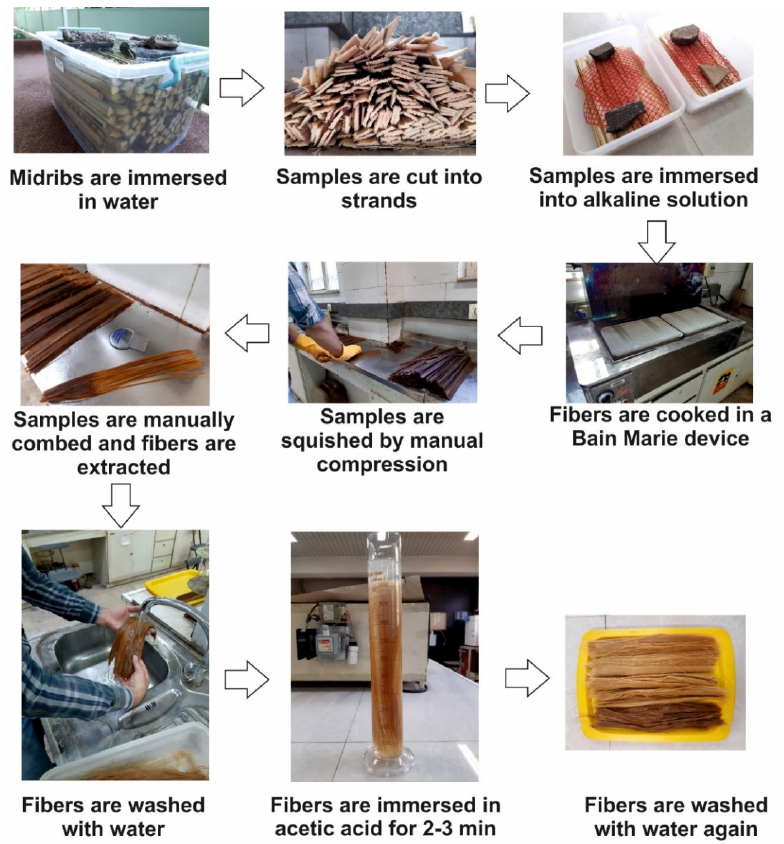
Figure 1. An illustration of the process of date-palm midrib long fibre extraction. The extracted date-palm fibres were longitudinally oriented and arranged to form flat sheets for stratified composite layers. The date-palm midrib long fibres were put in water until they converted to flat sheet form, then they were longitudinally oriented and pressed by hand and left for 24 h to dry under normal environmental conditions (tem- perature of 20 °C and 55% relative humidity of the air). The date-palm sheets formed this way had sizes (length × width) of about 350 mm × 350 mm. The midrib long fibres of date palm were used in the composition of three-layer laminate (D), with adjacent layers having perpendicularly oriented fibres, in the basic structure of the five-layer composites DC and DTC (Table 1). Table 1. The structure of experimental composites. Code